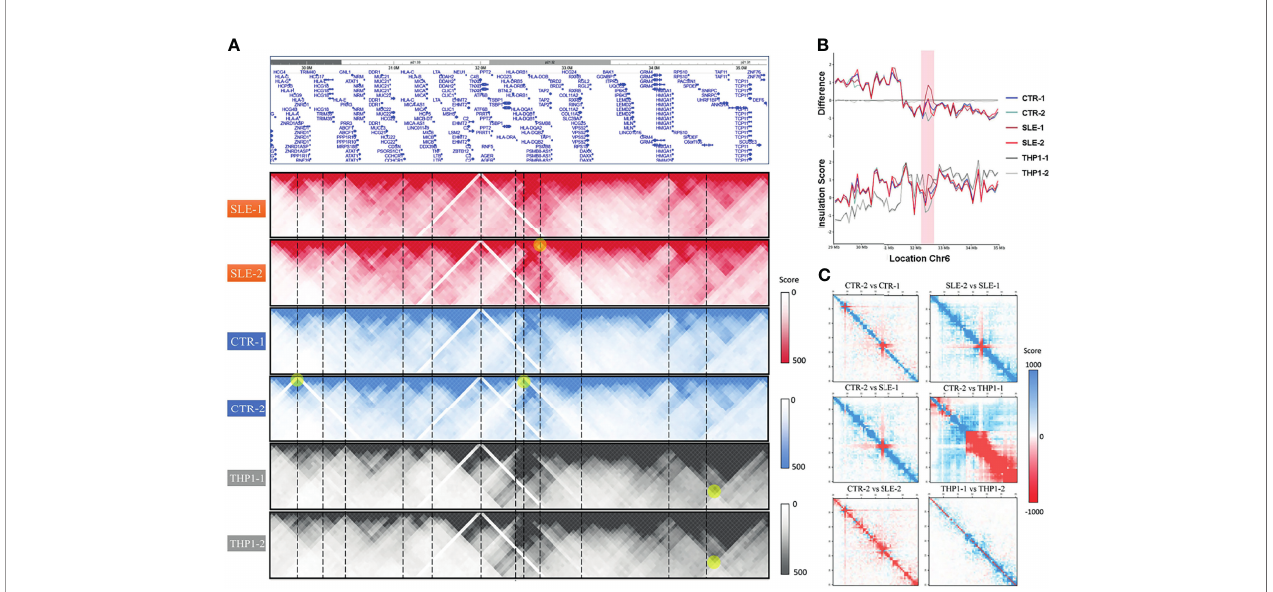
FIGURE 4 | The polymorphism around HLA complex region. (A) The HLA complex region in chromosome 6 (upper) and the chromatin interactions of six samples around this region. (B) The value of insulation score of six samples (lower) and their difference to THP1-1 around HLA complex region (chr6: 29Mb-35Mb, hg19). (C) The heatmaps of pair-wised difference